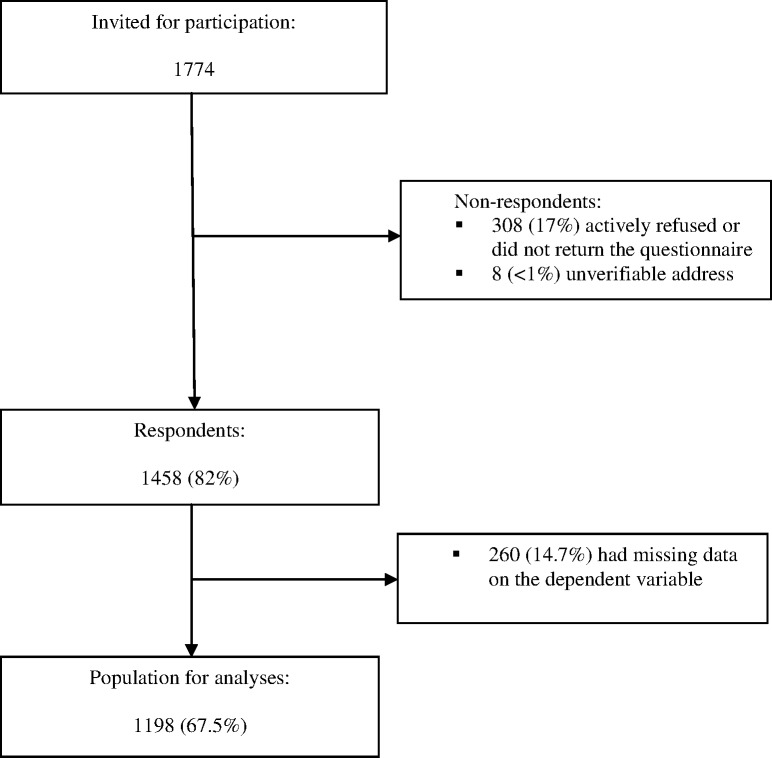
Flow-chart of study participants.For the present study, cross-sectional data from a larger longitudinal study among colorectal cancer survivors are presented. A flow diagram of participants in this longitudinal study has been published elsewhere[20]. The present study involves data obtained from survey 3 in December 2012.